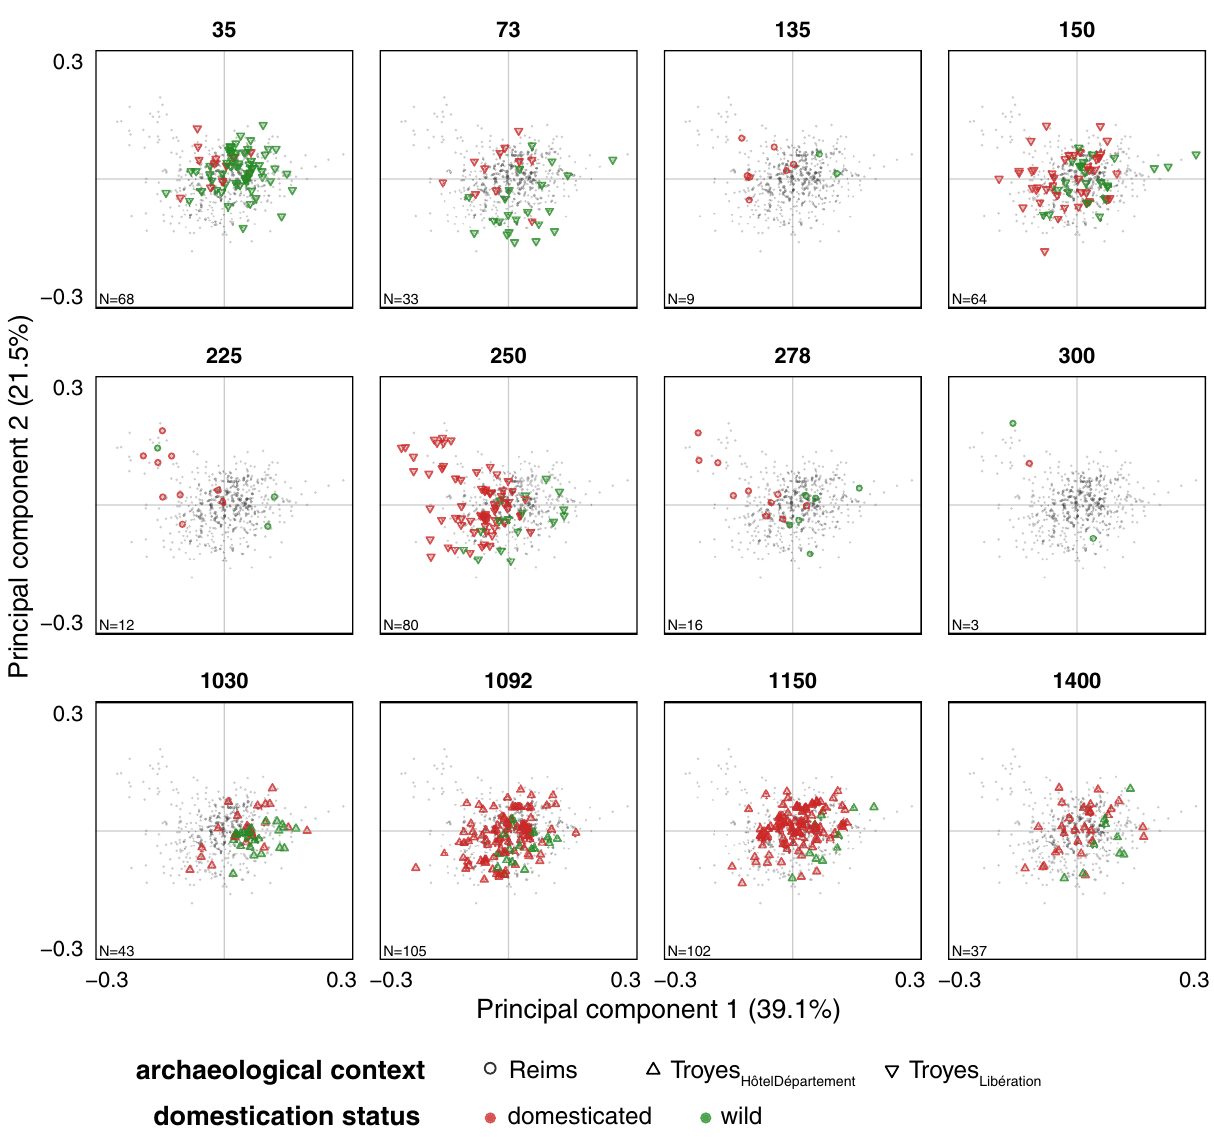
Figure 3. Principal component analyses on archaeological material. A single PCA is obtained (all grey spots), each facet highlights a phase, and each point corresponds to a pip. Symbols represent sites and colors report identification obtained with LDA status